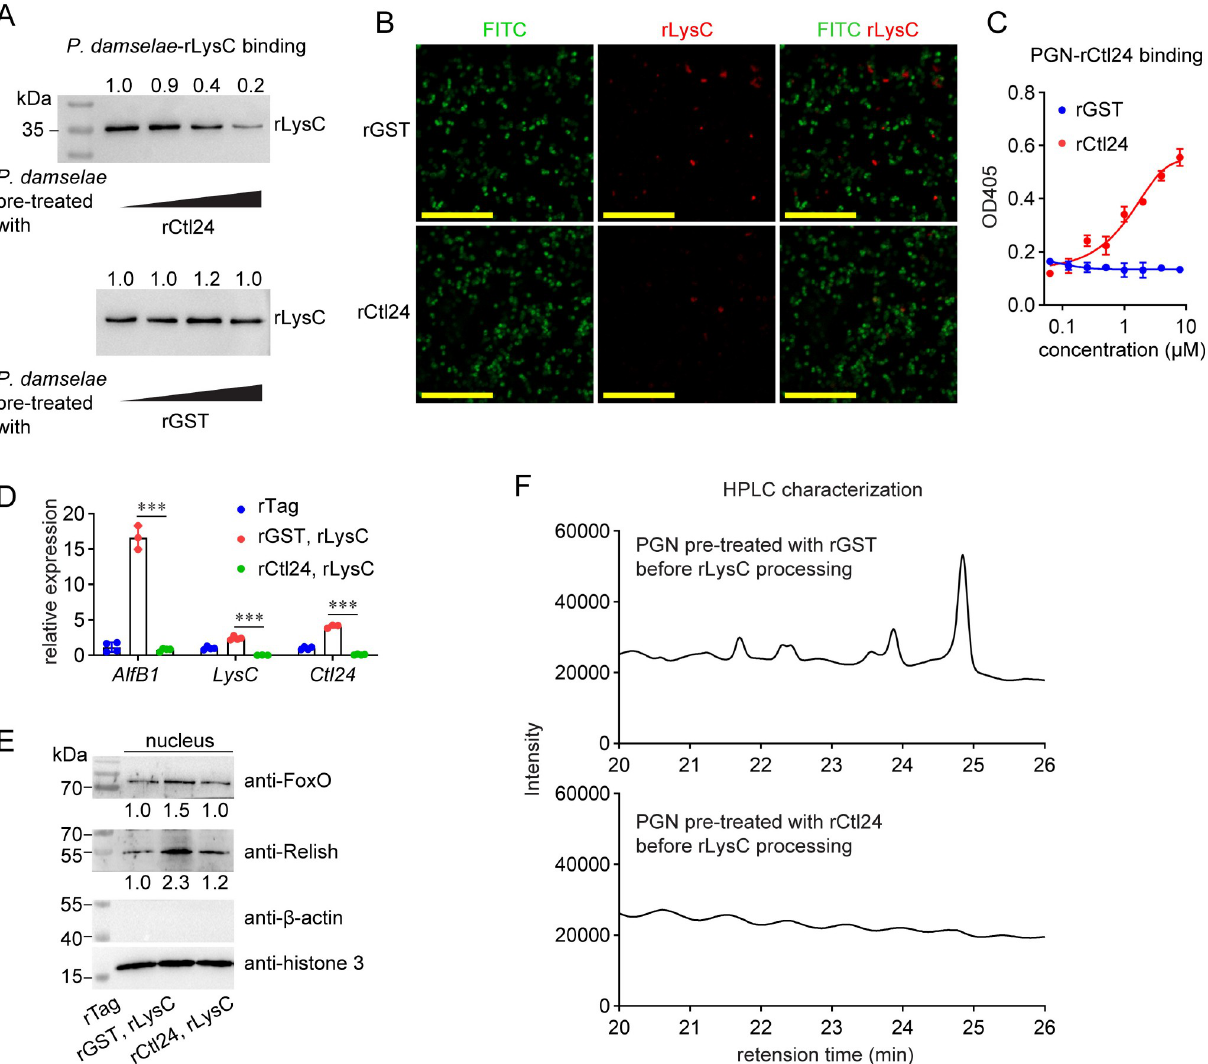
Fig 5. Inhibition of the immunomodulatory role of LysC by Ctl24. (A) Inhibition of P . damselae -rLysC binding by rCtl24. P . damselae were pre- treated with rCtl24 or control rGST, and then incubated with rLysC. The amount of rLysC bound to bacterial cells was detected by western blotting using anti-6His antibodies. (B) Inhibition of the deposition of rLysC onto P . damselae by Ctl24. FITC-labeled bacteria (green) were pre-treated with rCtl24, and then incubated with rLysC. rLysC deposition was visualized by anti-6His antibodies and Dylight 549 Goat Anti-Mouse IgG (red). Scale bar = 20 μ m. (C) Binding of P . damselae PGN by rCtl24. Gradient amount rCtl24 was added into 96-well plates pre-coated by PGN, and the binding of rCtl24 was detected by an ELISA assay. (D-E) Variation of intestinal immunity after feeding with rLysC-generated products when PGN was either or not pre-treated with rCtl24 before rLysC cleavage. P . damselae PGN was pre-treated with rCTl24 or rGST, and then incubated with rLysC. The digesting products were collected and introduced into intestines. Gene expression (D) and the nucleus level of FoxO and Relish (E) were detected another 6 h later. At least five shrimp were used for a sample. (F) Inhibition of the digestion of PGN by rLysC into muropeptides by rCtl24. P . damselae PGN was pre-treated with rCTl24 or rGST, and then processed with rLysC. The digesting products were analyzed by HPLC. All bar charts show the mean ± SD from three replicates. The images are representative of three repeats. Statistical analysis was performed using the Students’ t test. ��� , p < 0.001.